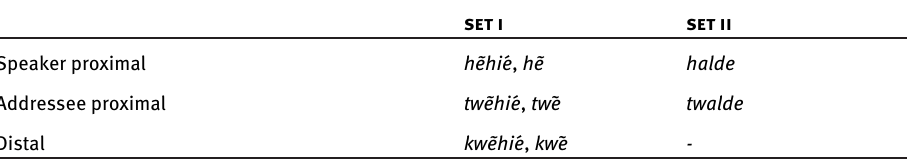
Table 4: Preliminary analysis of (ad)nominal demonstratives set i set ii Speaker proximal hẽhie ́, hẽ